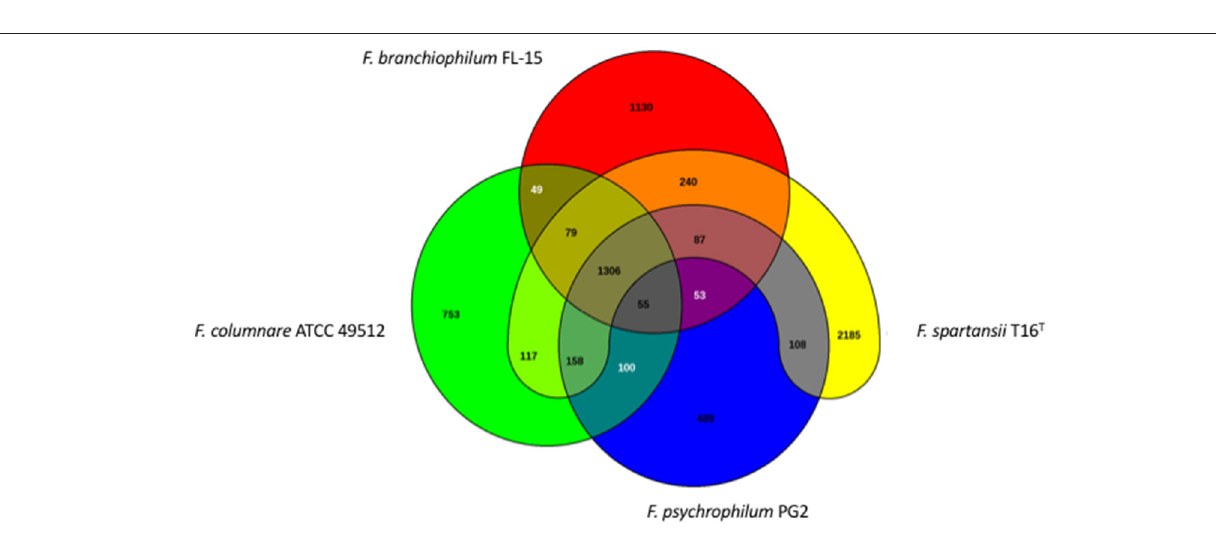
FIGURE 2 | Venn diagram of shared and unique genes in the selected Flavobacterium . The unique and shared genome among the compared genomes were determined using the BLAST score ratio approach of EDGAR 2.0 with a cutoff of 30% ( Blom et al., 2016).